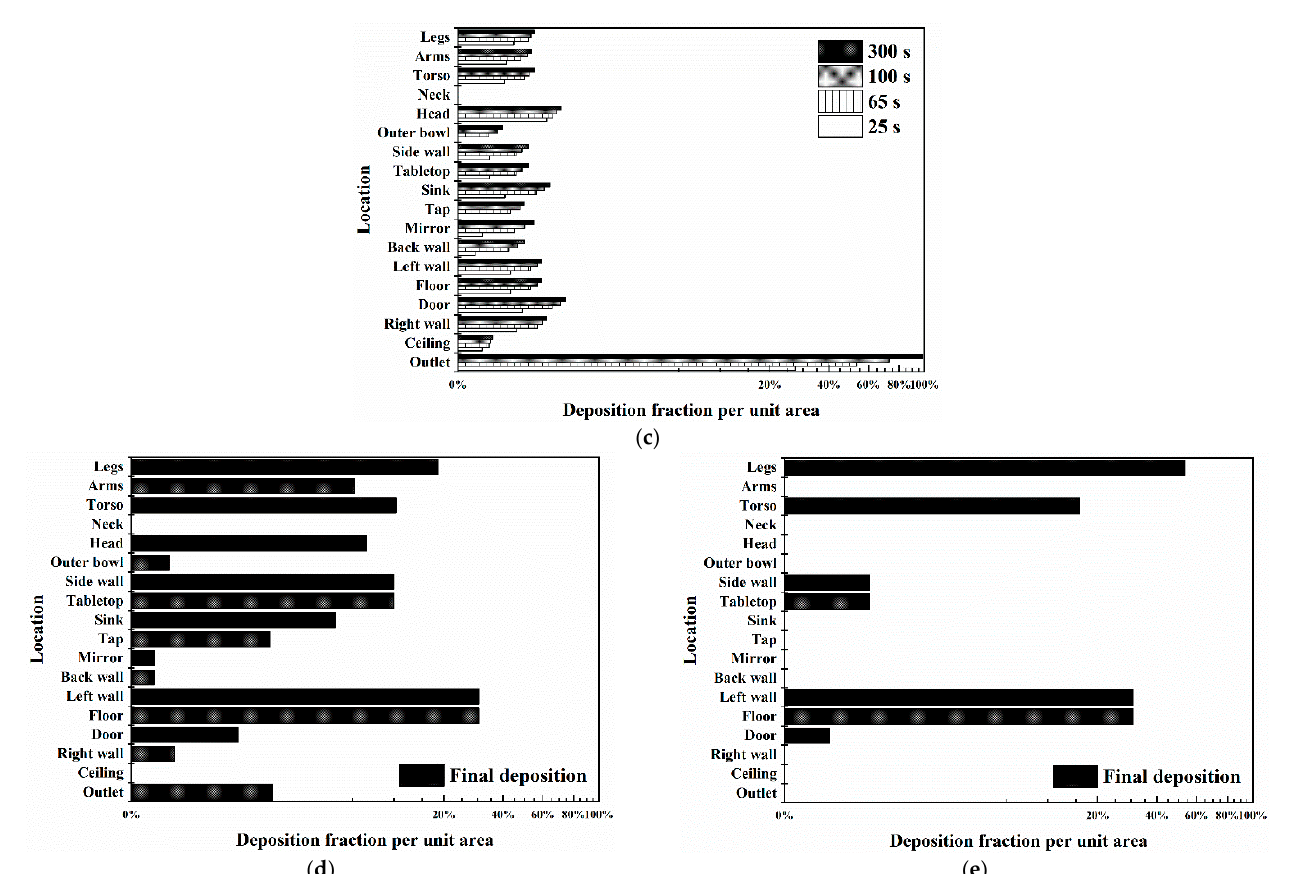
Figure A3. Final deposition of bioaerosols per unit area for Case 3 by size: ( a ) 1 µm; ( b ) 5 µm; ( c ) 10 µm; ( d ) 50 µm; ( e ) 100 µm.